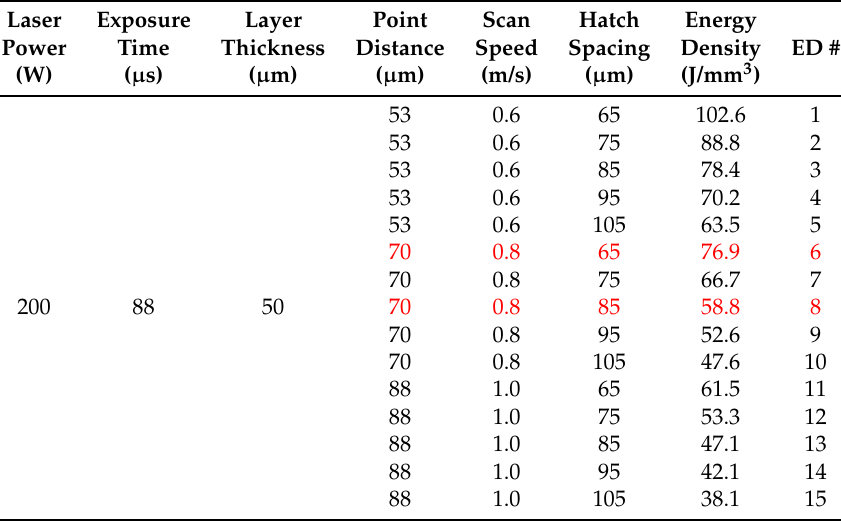
Table 2. Process parameters used to fabricate 304L stainless steel.